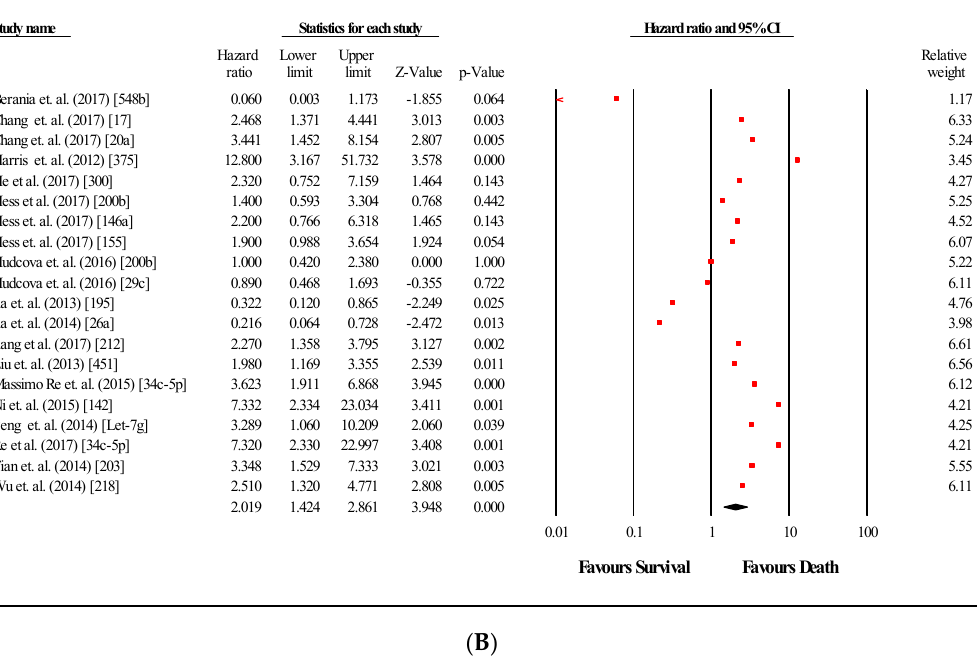
Figure 2. Forest plots for the miRNAs associated with OS. ( A ) Upregulated miRNA; ( B ) Downregulated miRNA.